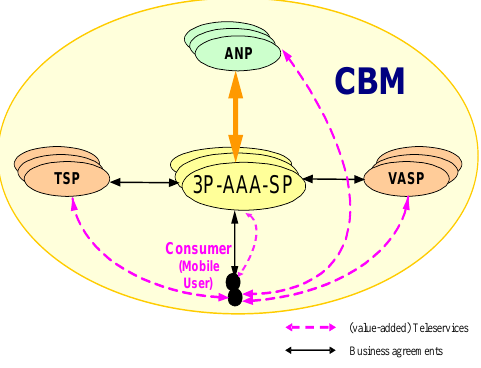
Figure 1. The consumer-based techno-business model (CBM), c.f.